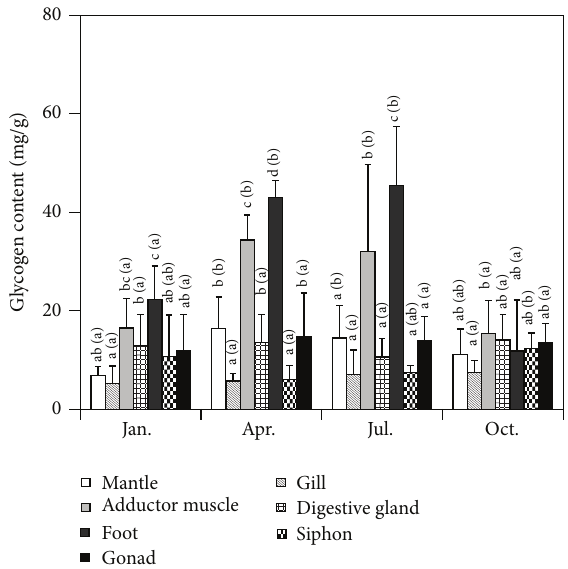
Figure 4: Seasonal changes in glycogen content in different tissues removed from Manila clams, Ruditapes philippinarum . Bars repre- sent mean and whiskers represent standard deviation. 3–6 samples (replicates) were used for the analysis of each organ. No common letters out of parentheses indicate significant differences of glycogen contents in different tissues on each month and no common letters in parentheses indicate significant differences of seasonal changes on each tissue ( 𝑃 < 0.05 ; Tukey-Kramer